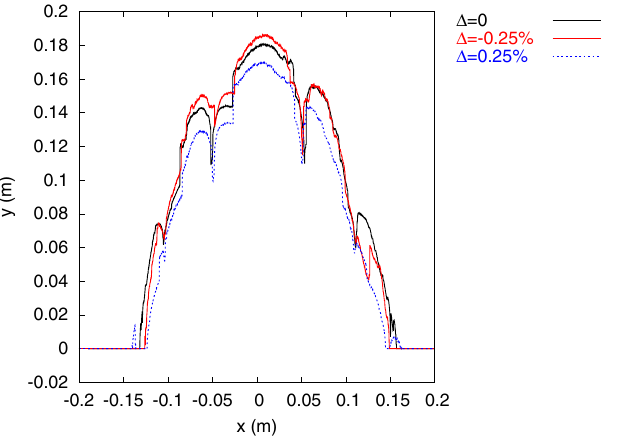
FIG. 40. Closed orbit distortion (rms value) without and with correction (in red, horizontal distortion and in blue vertical